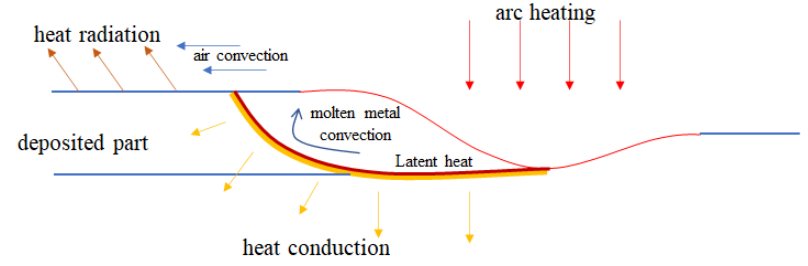
Figure 3. Schematic illustration of the thermal boundary conditions of the molten pool.